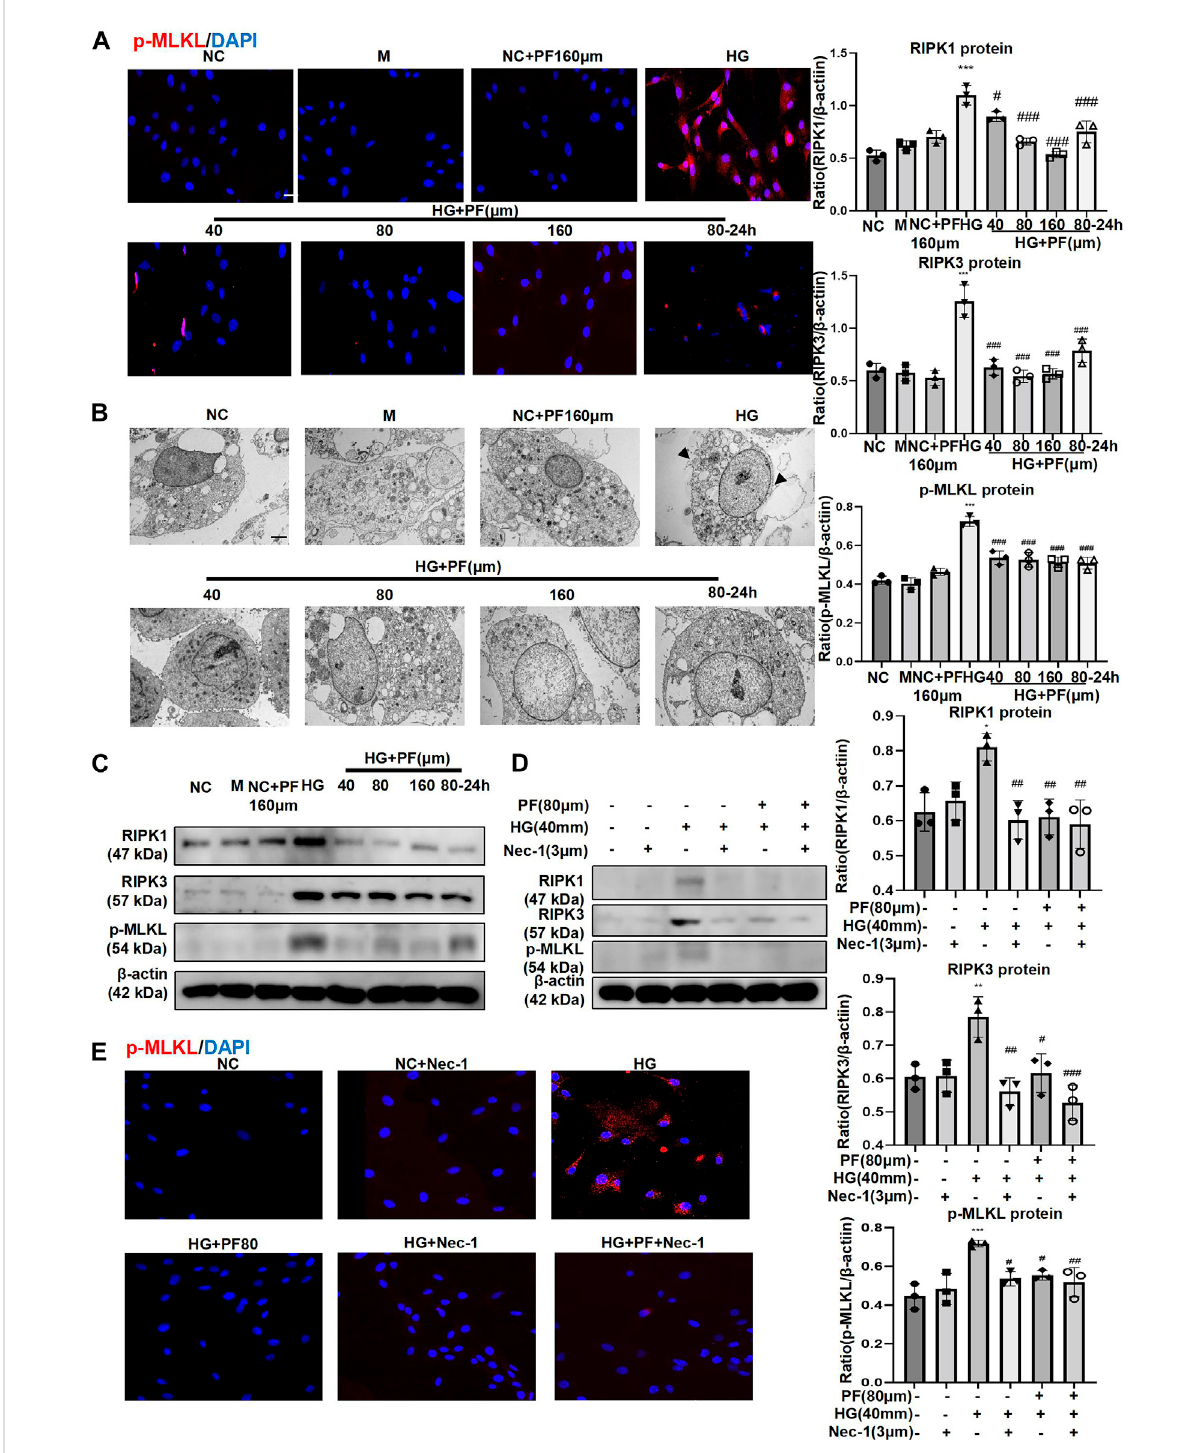
FIGURE 7 PFregulatespodocytenecroptosisstimulatedbyHG. (A) IFstainingofp-MLKLproteinsexpressioninMPC5cellsstimulatedwithHGandtreated with PF. Scale bar = 50 μ m. (B) Images of MPC5 cells observed by TEM. (C) WB assay of RIPK1, RIPK3, and p-MLKL proteins in MPC5 treated with HG and PF. (D) WB assay of RIPK1, RIPK3, and p-MLKL proteins in MPC5 treated by Nec-1. (E) IF staining of p-MLKL proteins expression in MPC5 treated by Nec-1. Scale bar = 50 μ m. Results represent themean ± SD. * p < 0.05, ** p < 0.01, *** p < 0.001 vs. NC; # p < 0.05, ## p < 0.01, ### p < 0.001 vs. HG. NC, normal control (5.5 mmol/L glucose); HG, high glucose (40 mmol/L); M, mannitol (34.5 mmol/L mannitol +5.5 mmol/L glucose); PF, paeoni fl orin;WB,Westernblotting;MPC5,mousepodocyteclone5;Nec-1,necrostatin-1;TEM,transmissionelectronmicroscopy;RIPK1,receptor- interacting serine/threonine kinase 1; RIPK3, receptor-interacting serine/threonine kinase three; MLKL, mixed-lineage kinase domain-like